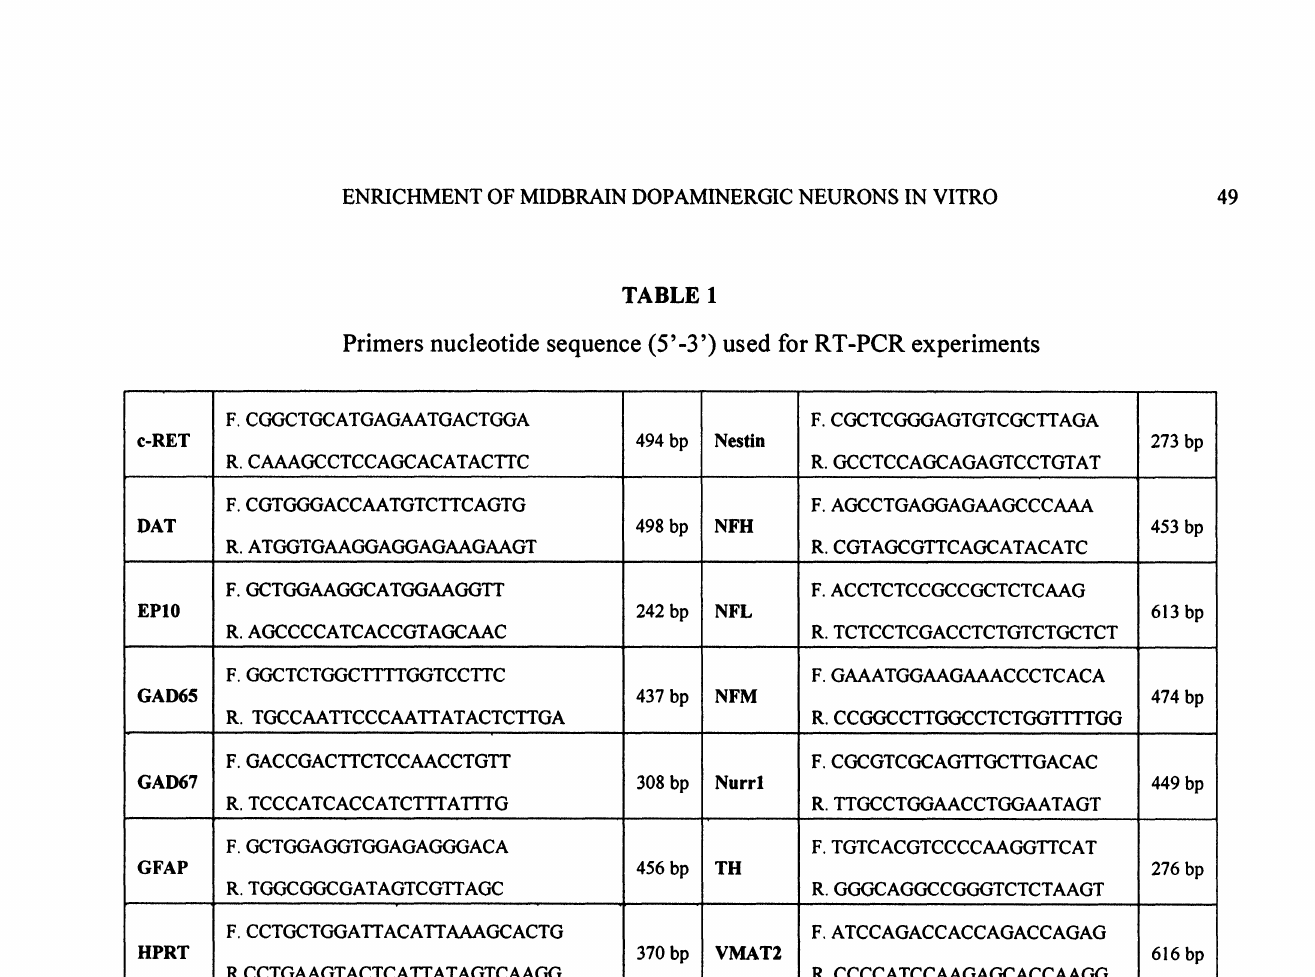
Primers nucleotide sequence (5’-3’) used for RT-PCR